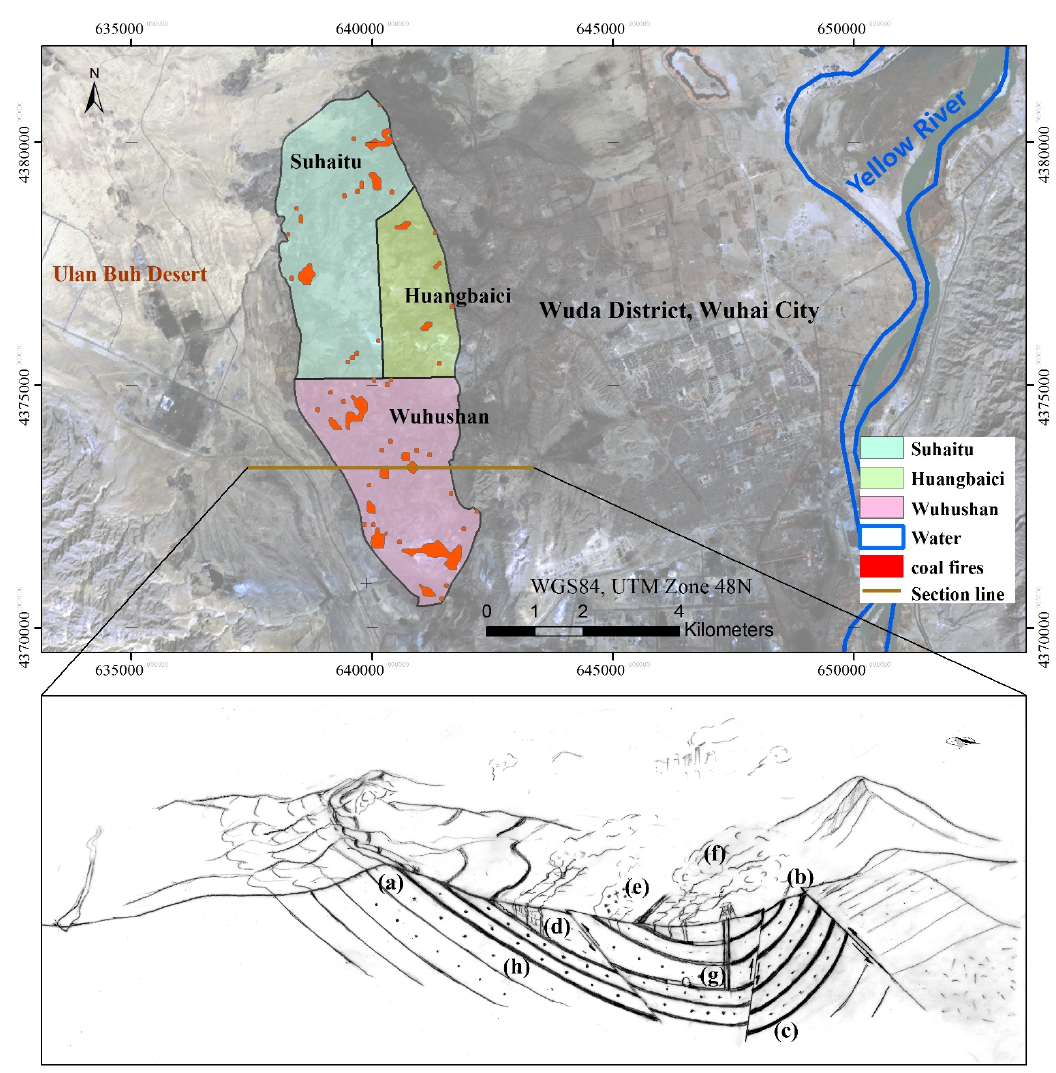
Figure 1. Location of the study area (Wuda coal field) and geology of the field. Top: coal fires are shown for three active coalmines in the field with coal fire polygons (red) depicting fires for 22:58 22 June 2013, mapped using self-adaptive gradient-based thresholding (SAGBT) (local time = UTC + 8); Bottom: east-west geological section along the southern part of the field and including: ( a ) coal seam outcrops; ( b ) thrust fault line; ( c ) coal seams; ( d ) cracks and vents; ( e ) coal tar precipitation spots; ( f ) mining laneway system; ( g ) smoke and steam; and ( h )